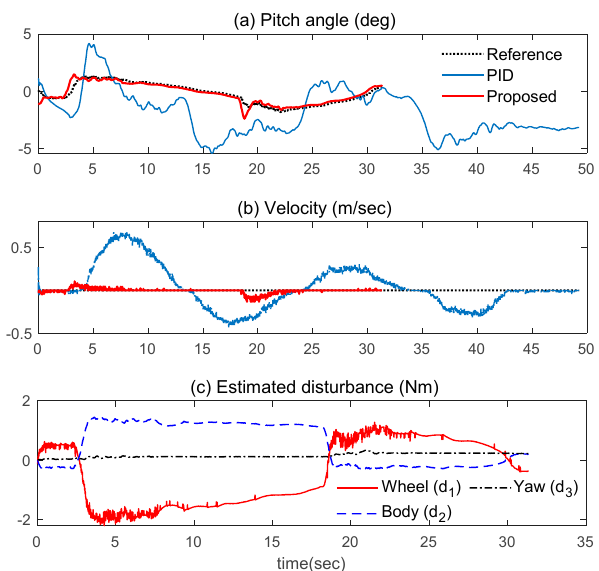
Figure 12. Effect of the longitudinal eccentricity.